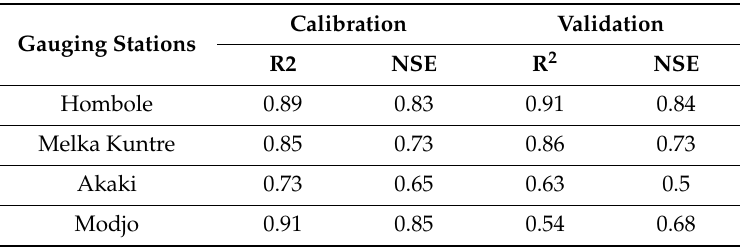
Table 5. Statistical values of stations for calibration and